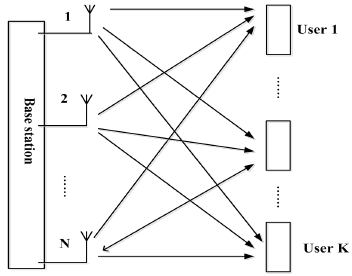
Figure 1 . The model of massive MIMO system